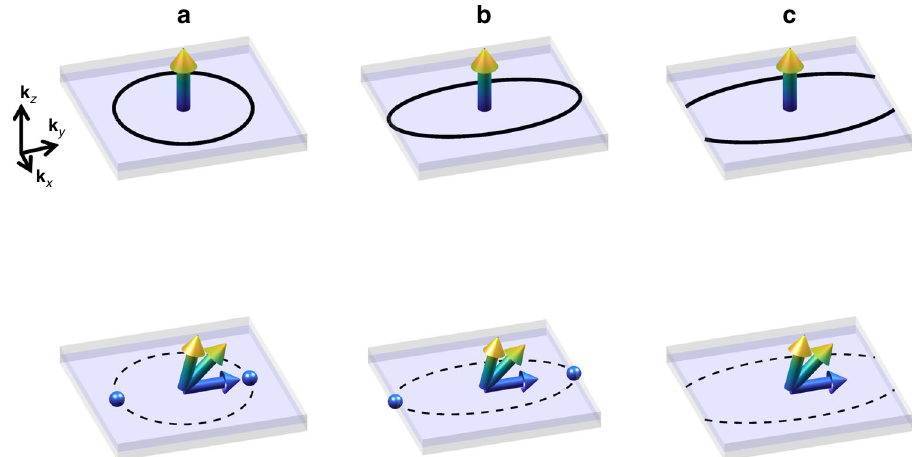
Fig. 4 Schematic transition between nodal rings and Weyl points. a The nodal ring (solid ring) is protected by the in-plane mirror symmetry where the spin (arrow) points out of plane, in the upper panel. If the spin rotates to break the mirror symmetry, the nodal ring gets gapped out (dashed ring), giving rise to a pair of Weyl points (blue spheres). The induced AHE is proportional to the separation of the Weyl points, that is, the diameter of the nodal ring ( k d ) in a form e 2 h k d , where a is the lattice parameter. b The nodal ring is as large as the Brillouin zone size, as a critical point. The resultant Weyl point is 2 π a pushed to the zone boundary and meets another Weyl point with opposite chirality from the second zone. The induced AHE is quantized to e 2 h 1 a . c The nodal ring is larger than the Brillouin zone size, as an open nodal ring. Then, the gapped ring does not induce Weyl points in the open direction, generating a 3D quantized Hall conductivity, e 2 h 1 a